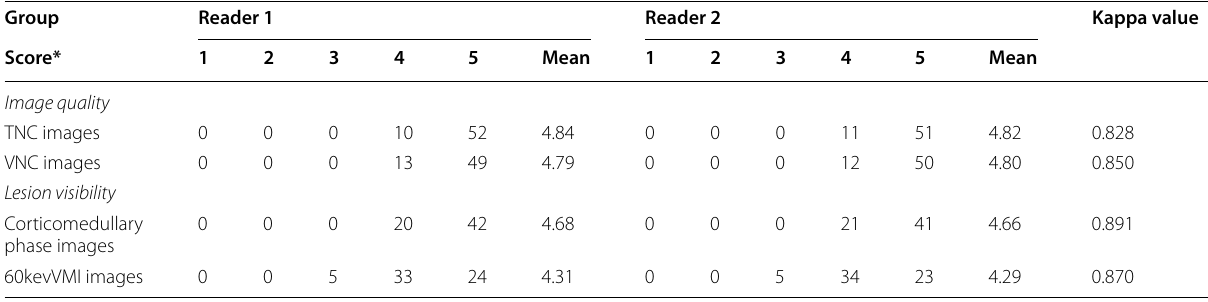
*The scores were obtained according to the Likert scale from 1